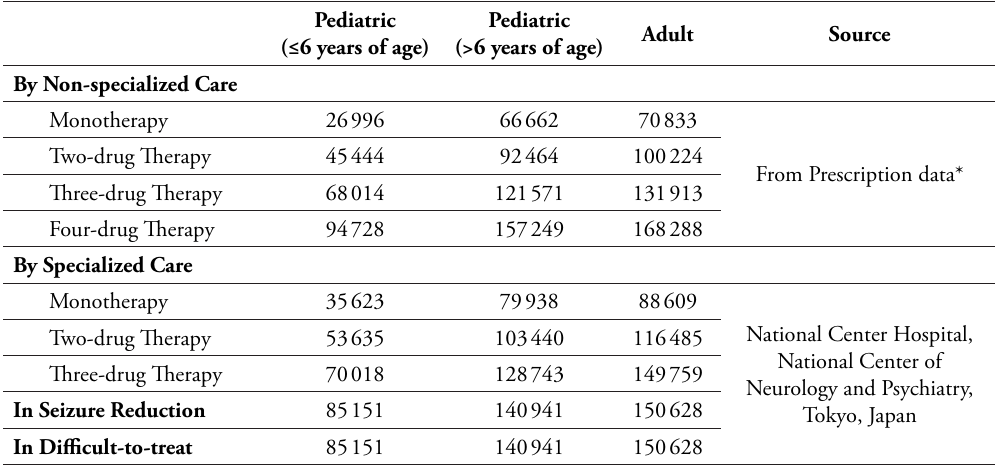
Table 3: Cost Parameters for 3 Months